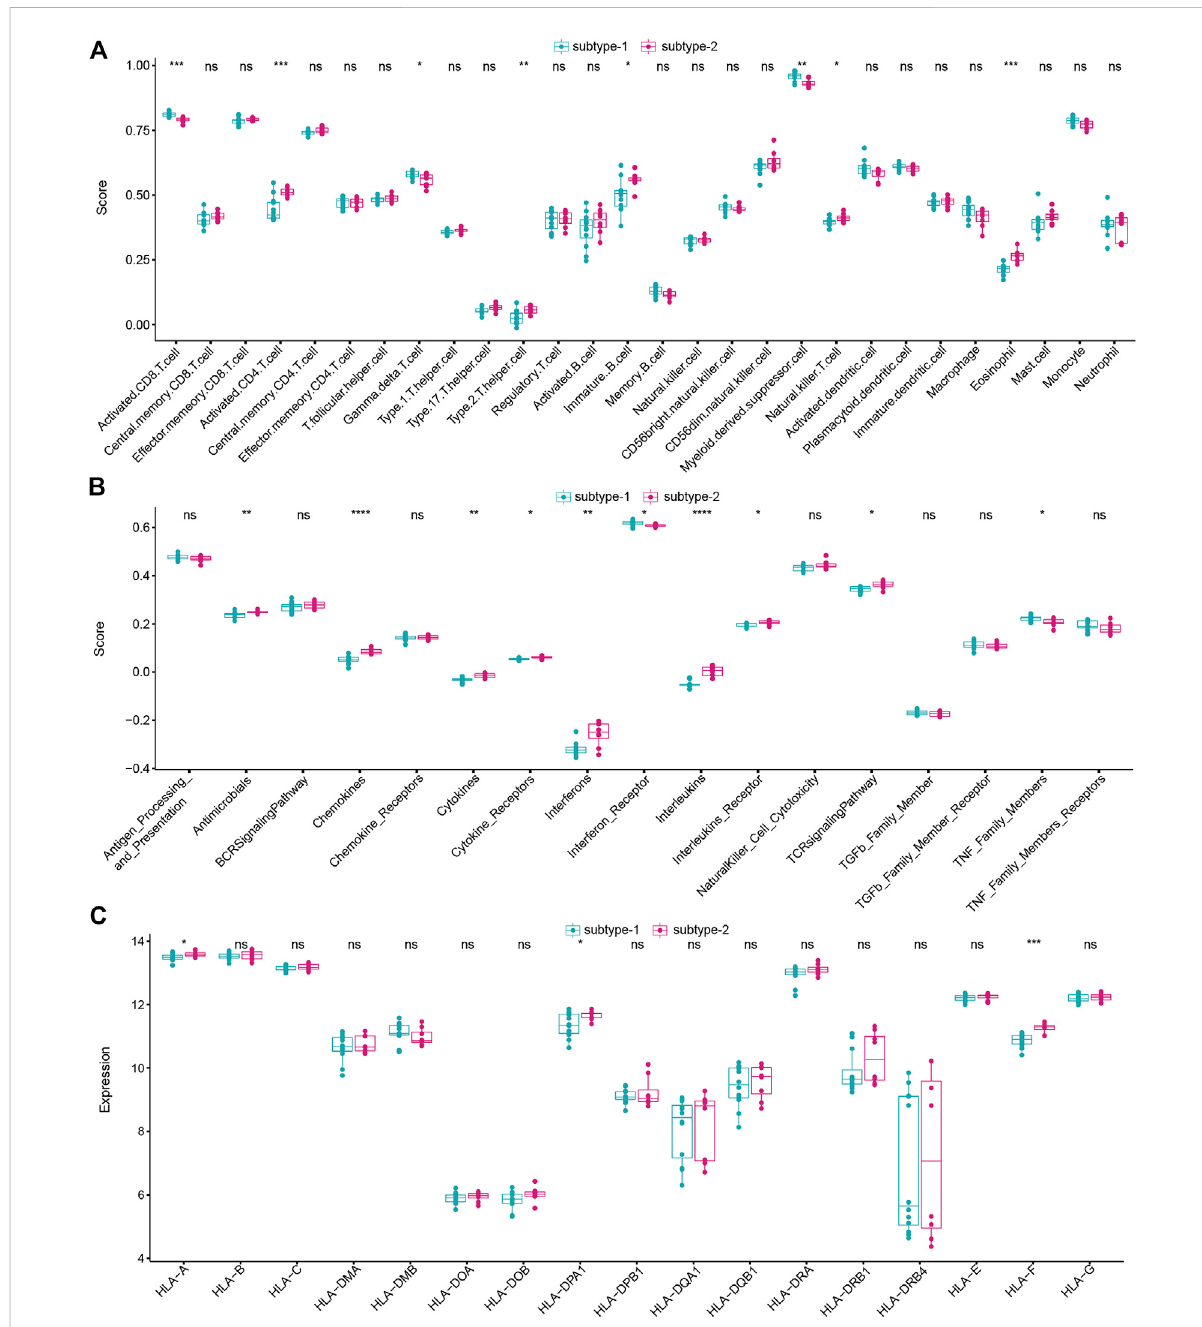
FIGURE 6 Different immune characteristics of two distinct autophagy subtypes. (A) Abundance differences of each immune immunocyte in two autophagy expression subtypes. (B) Activity differences of each immune reaction in two autophagy expression subtypes. (C) Expression differences of each HLA gene in two autophagy expression